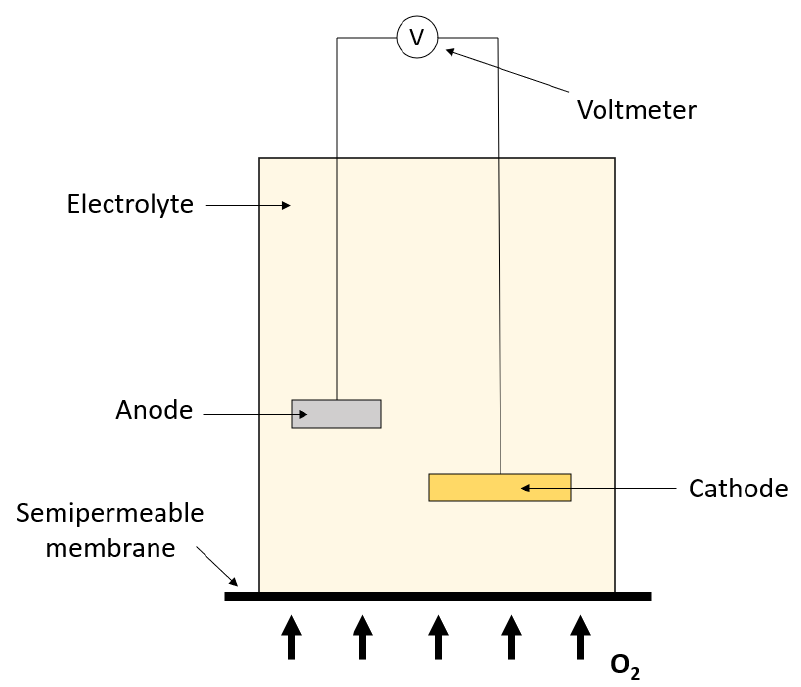
Figure 7. Schematic drawing of a galvanic fuel cell (GFC) oxygen analyzer. When O 2 molecules enter the measurement cell, by diffusion through the membrane, they are reduced at the cathode to hydroxide ions and are subsequently oxidized at the anode. The cathode, anode and overall reaction in case of a lead anode are shown in Reaction (R 1) to (R 3),